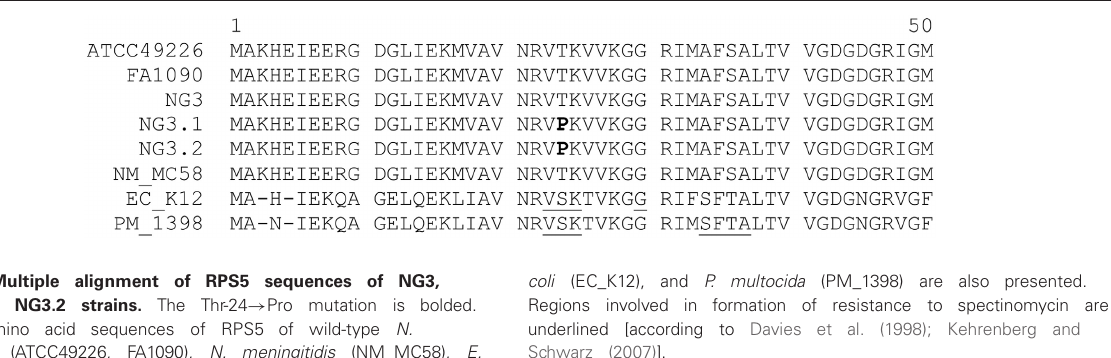
Table 2 ) and 2 units of TermiPol DNA Polymerase (Solis Biodyne, Estonia) according to the followed profiling: 94 ◦ C for 20 s, 58 ◦ C for 20 s, and 72 ◦ C for 15 s, in 70 cycles.